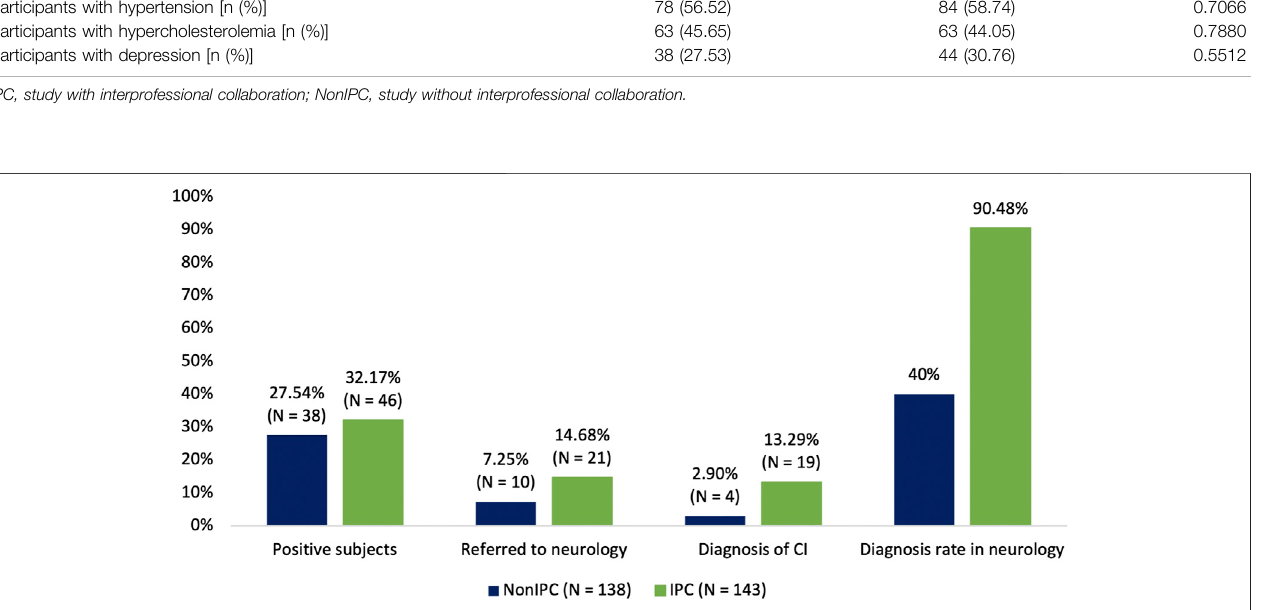
Frontiers in Pharmacology |